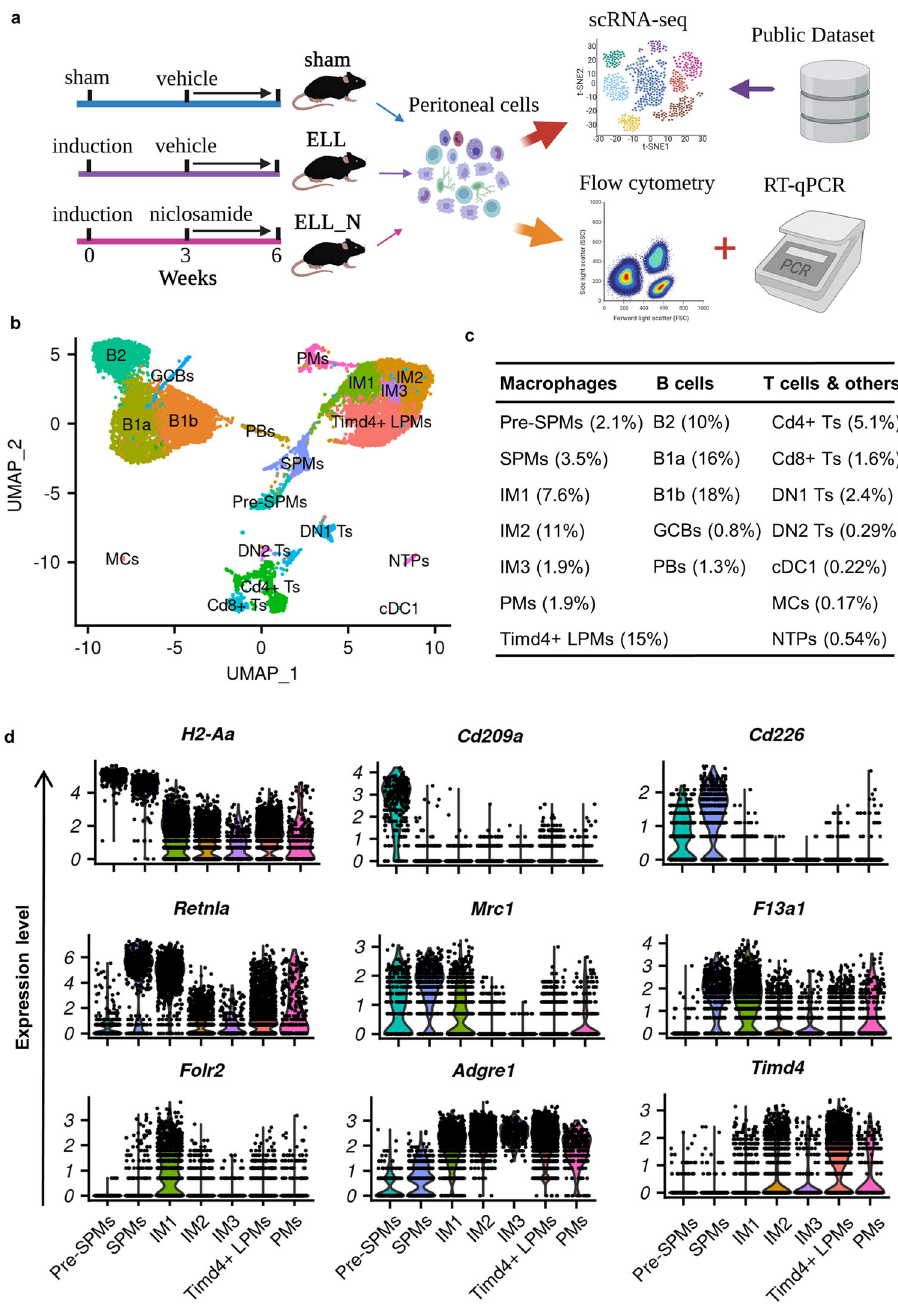
Fig. 1 Single-cell transcriptomic pro fi ling of peritoneal immune cells. a Schematic of the experimental pipeline. Created with BioRender.com b UMAP visualization of peritoneal immune cells. c Ratio of each population in cell number. d VlnPlot of characteristic gene expressions for macrophage subpopulations. Sham sham control, ELL endometriosis-like lesions, ELL_N niclosamide administration to ELL-induced mouse, Pre-SPMs premature “ small ” peritoneal macrophages, SPMs “ small ” peritoneal macrophages, IM1-3 intermediate macrophages subtype 1-3, Timd4 + LPMs Timd4 + “ large ” peritoneal macrophages, PMs proliferating macrophages, B1a B1a cells, B1b B1b cells, B2 B2 cells, GCBs germinal-centre B cells, PBs plasma blast B cells, Cd4 + Ts Cd4 + T cells, Cd8 + Ts Cd8 + T cells, DN1 double negative T cells 1, DN2 double negative T cells 2, cDC1 conventional dendritic cells 1, MCs Mast cells, NTPs